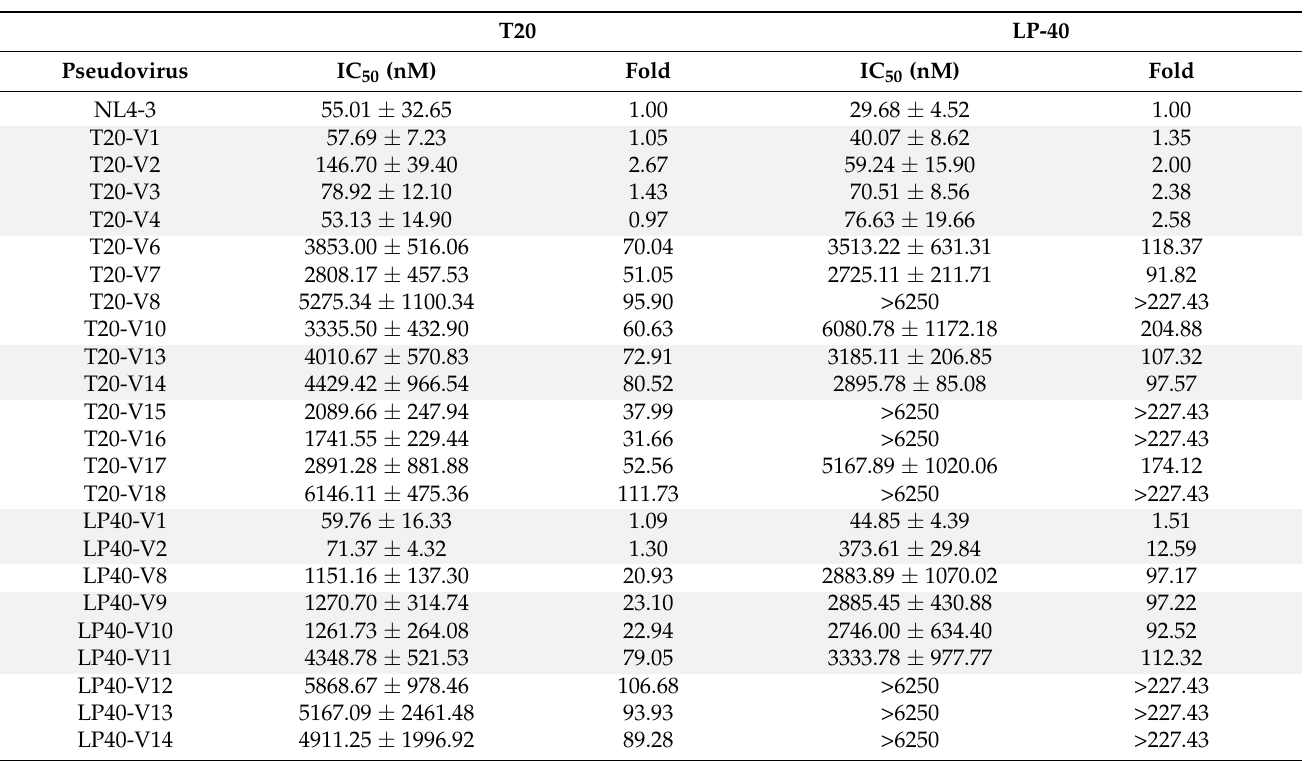
Table 1. Resistance profiles of T20- and LP40-resistant mutants to T20 and LP-40. The experiment was performed in triplicate and repeated three times. The background colour to distinguish between different